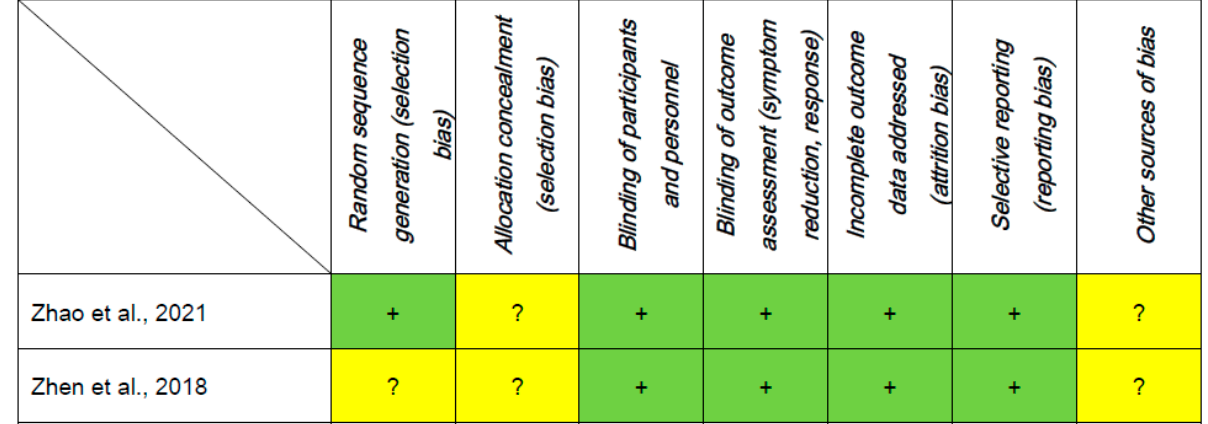
Figure 2. Risk of bias [23,24]. Abbreviations: + or green: low risk of bias; ? or yellow: unclear risk of